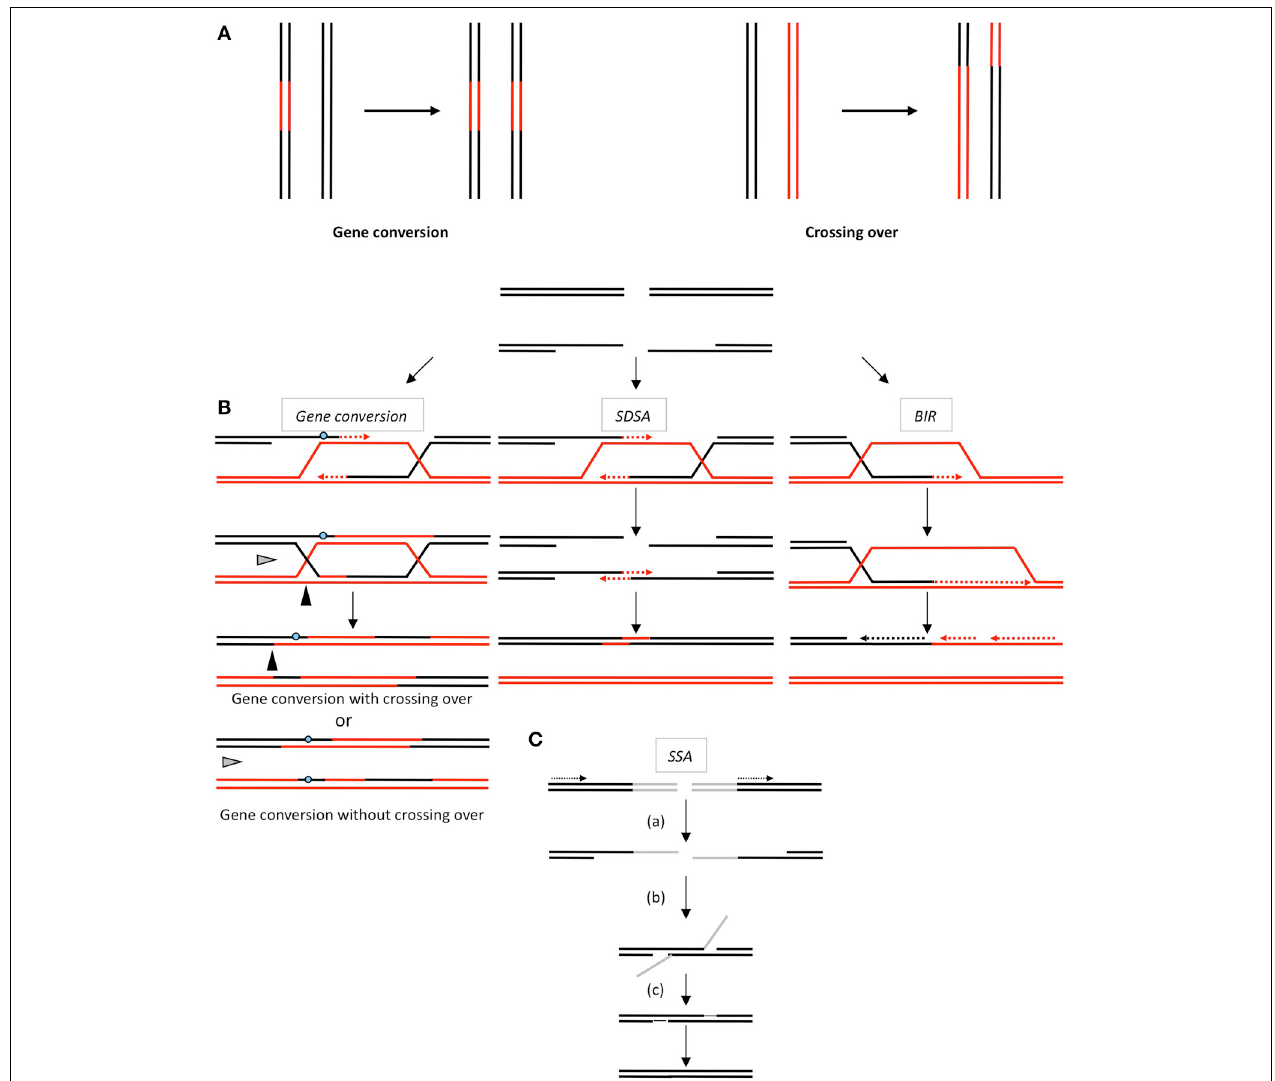
FIGURE 1 | (A) The products of HR. Gene conversion (left panel) leading to non-reciprocal exchange of a DNA sequence (in red). Crossing over (right panel): reciprocal exchanges of adjacent sequences (black and red). Note that gene conversion can be associated with or without crossing over. (B) The double-strand break repair models through HR. Left panel: Gene conversion. After resection, the single-stranded 3 (cid:4) -tail invades a homologous, intact double-stranded DNA, forming a D-loop (displacement loop). This process tolerates limited imperfect sequence homologies, thus creating heteroduplex intermediates bearing mismatches (blue circle). The invading 3 (cid:4) -end primes DNA synthesis, which then fills in the gaps. The cruciform junctions (Holliday junctions, HJ) migrate. Resolution (or dissolution) of the HJ occurs in two different orientations (black or gray triangles), resulting in gene conversion either with or without crossing